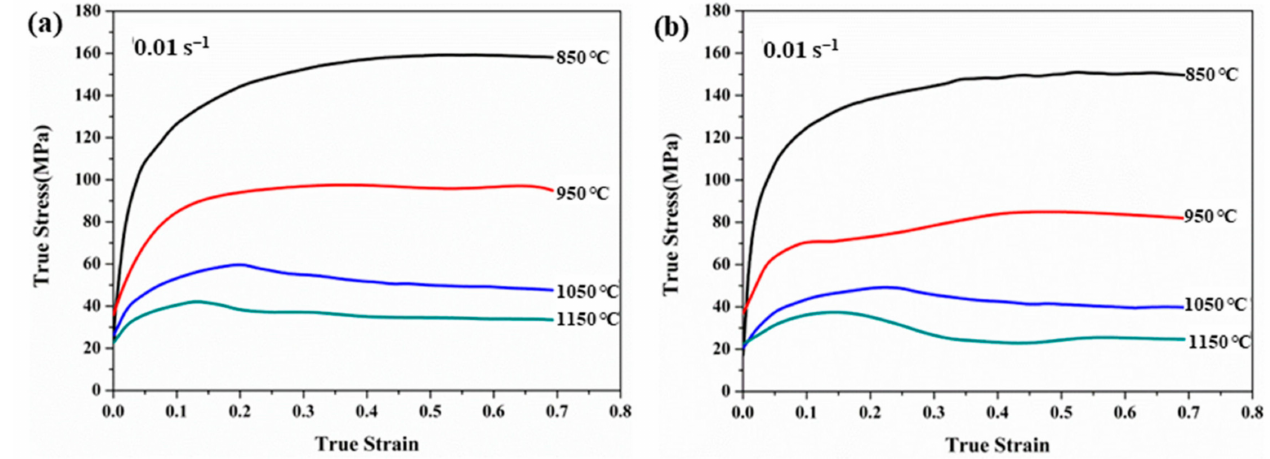
Figure 4. True stress–strain curves of 35CrMo ingots at strain rate of 0.01 s − 1 and different cast conditions: ( a ) without ultrasonic, ( b ) with